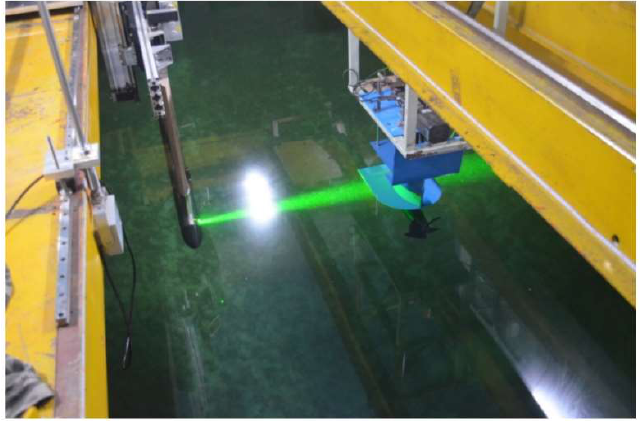
Figure 5. Photograph showing the flow-field measurement of the L-type podded propulsor by PIV.